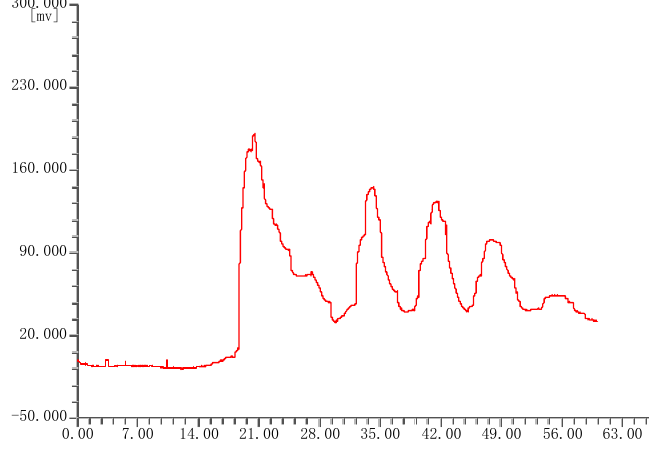
Figure 4. A curve that fits the fingerprint of Psorslea corylifolia L. Table 6. Similarity of Psorslea corylifolia L.